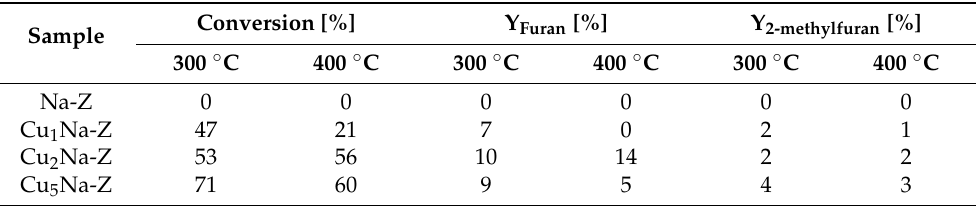
Table 4. The influence of Cu content and temperature on catalytic properties of Brønsted acid sites-free